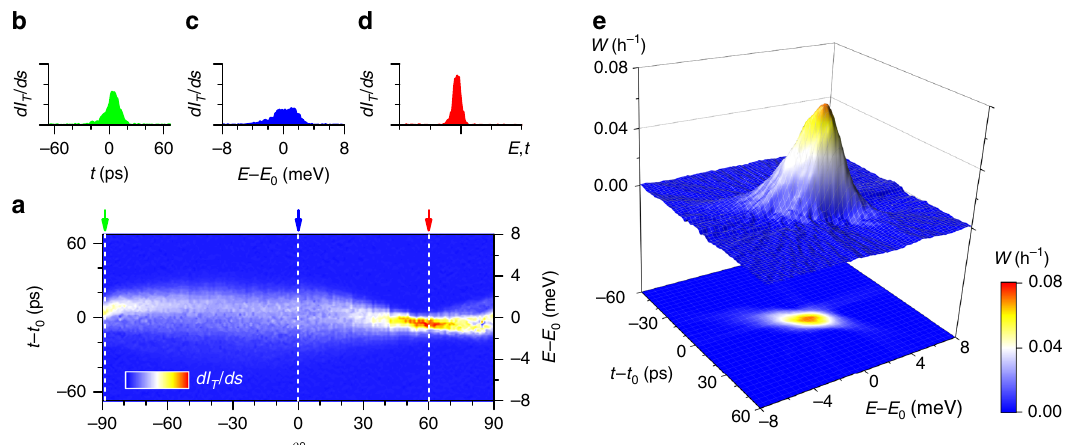
Fig. 2 Angle dependent projection of single electron density. a Colour plot: projected electronic density (sinogram) at various angles θ in the energy – time plane. Colour scale corresponds to dI T = dS , where dS is an incremental step in the (normalised) energy – time plane. Depending on θ , the projection axis S corresponds to an energy projection, time projection or a mixture. The left axis is appropriate for θ ¼ ± 90 (cid:5) and the right hand for θ ¼ 0 (cid:5) . Selected projections are shown at angles, where S corresponds to b time projection, c energy projection and a mixed projection d . e Inverse Radon transform of the data in a giving the Wigner phase-space density in units of h (cid:2) 1